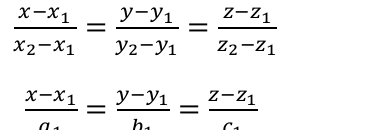
Figure 5. Point cloud data of selected frames